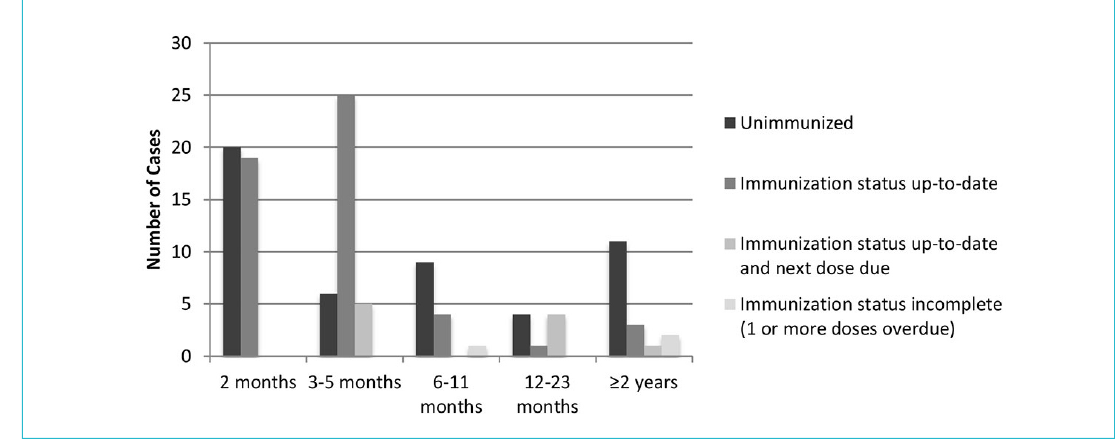
Figure 3: Immunisation status of children hospitalised due to